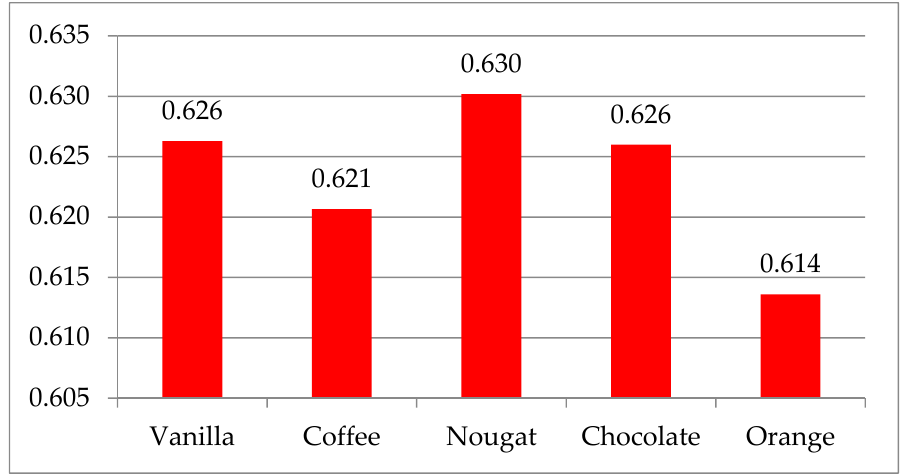
Figure 6. Engagement score in measuring the impact of the aromas on emotional engagement. Using a single-factor variance analysis, we determined the statistically proven differ- ence between the samples of aromatic compounds for the interest indicator. We tested the hypotheses at a significance level of